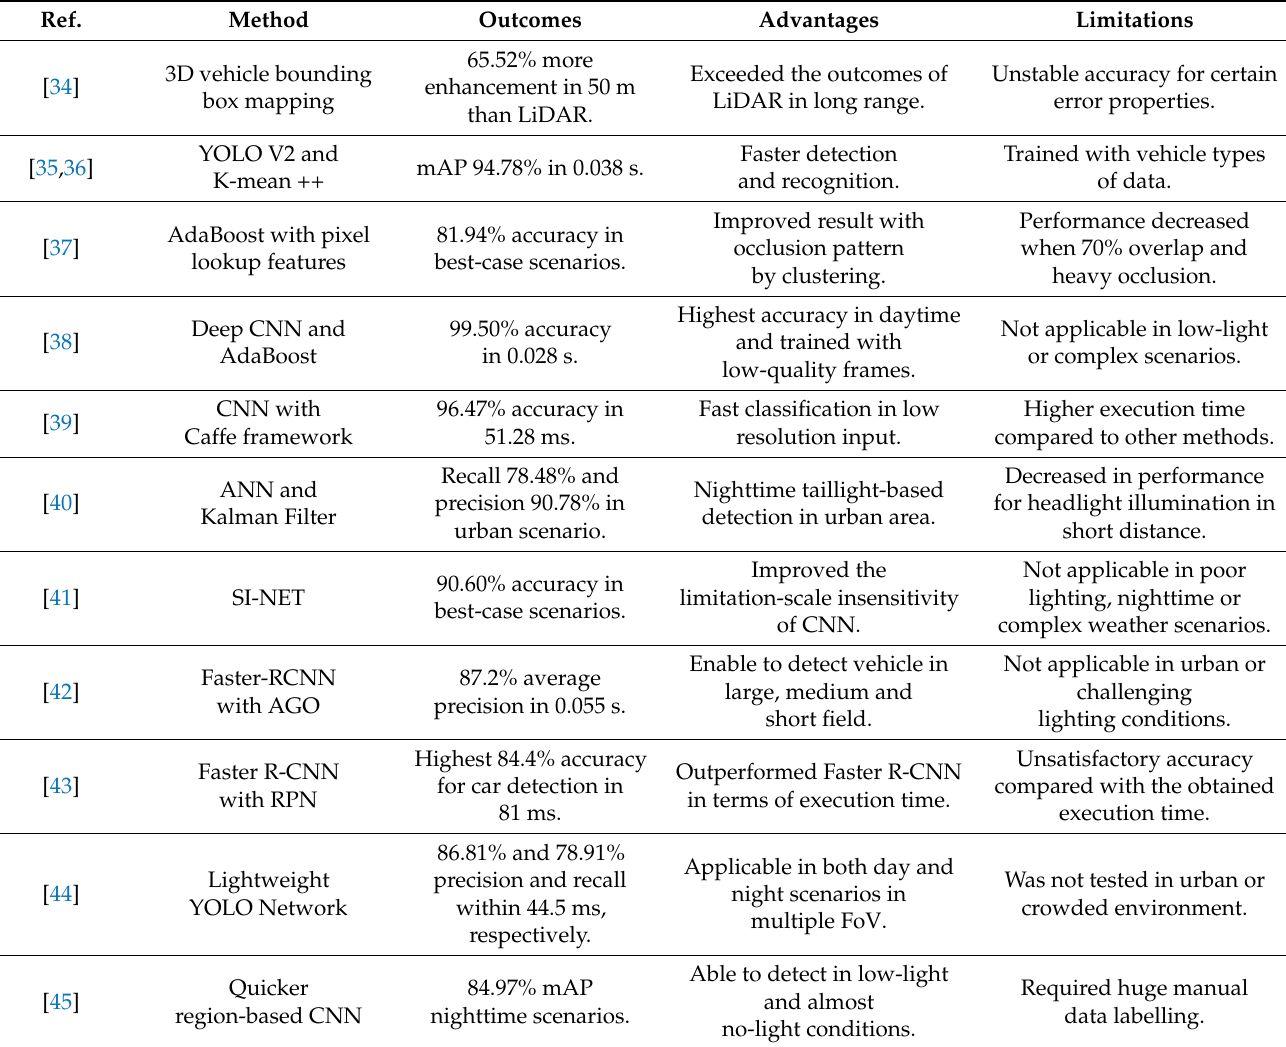
Table 5. Summary of multiple deep learning methods for vehicle